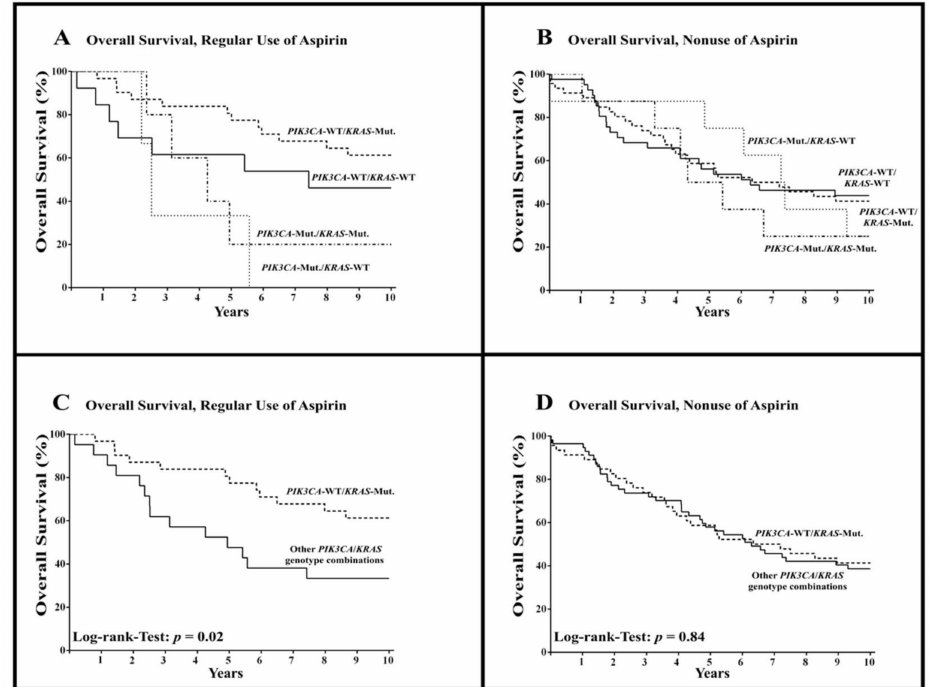
Figure 3. Overall survival among patients with colorectal cancer according to PIK3CA and KRAS mu- tational status and regular use or nonuse of aspirin after diagnosis. WT = wild-type, Mut. = mutated. ( A , B ) show overall survival among all combinations of mutational status in patients with regu- lar use of aspirin ( A ) and nonuse of aspirin ( B ), respectively, while ( C , D ) show overall survival among patients with combined wild-type- PIK3CA and mutated- KRAS tumors compared to other PIK3CA/KRAS genotype combinations (except PIK3CA-WT/KRAS -Mut.). When reviewing the combined PIK3CA and KRAS mutational status of patients with regular aspirin use, a significant overall survival benefit for patients with combined wild- type PIK3CA and mutated- KRAS tumors was observed (HR = 0.38; 95% CI = 0.17–0.87; p = 0.02; Figure 3C, Table 2). This survival advantage was not observed in patients without aspirin use (HR = 0.95; 95% CI = 0.58–1.57; p = 0.84; Figure 3D, Table